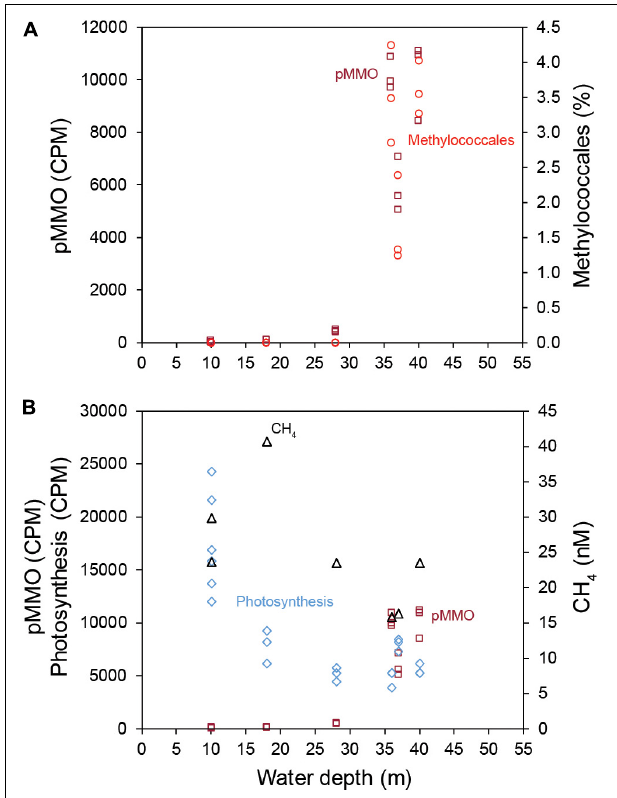
FIGURE 6 | (A) The relationship between water depth ( x -axis), the relative abundance (%) of Methylococcales (16S rRNA gene 2018 data, red), and pMMO transcripts (CPM, dark red). (B) The relationship between water depth and CH 4 concentration in the surface water (black symbols), pMMO transcripts (CPM, dark red), and the sum of transcripts belonging to the GO category photosynthesis (CPM, light